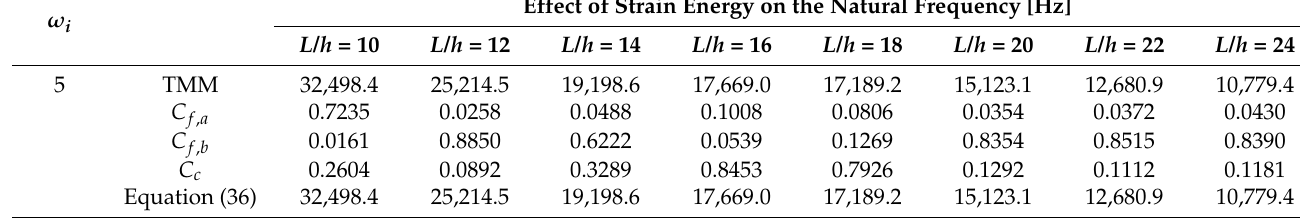
Table 6. Effect of strain energies on the natural frequencies of three-layered beams with the C-F end condition depending on the variation in L/h.